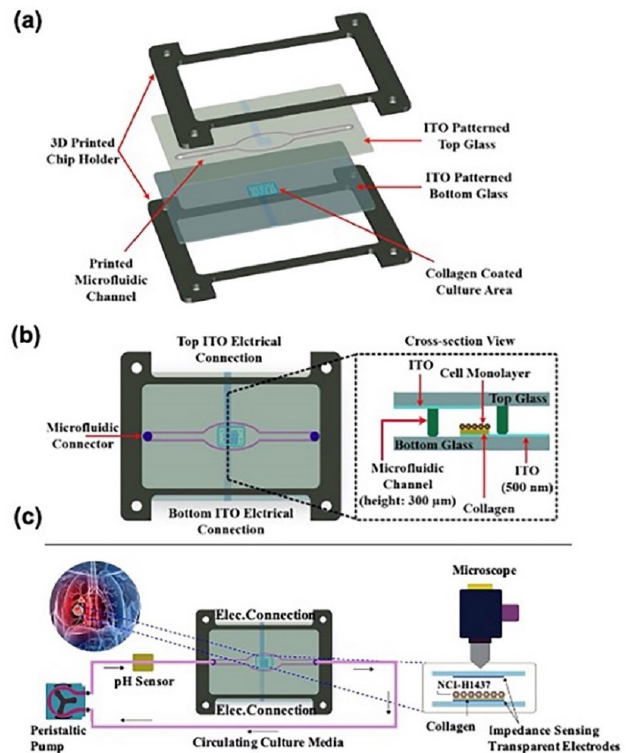
Figure 4. Lung-cancer-on-chip system with multiple sensors: ( a ) Cross-section view and ( b ) top view of microfluidic glass chip fabrication. ( c ) Working flow of the chip for physiological environment monitoring and drug cytotoxicity evaluation. Reproduced with permission from [54] .